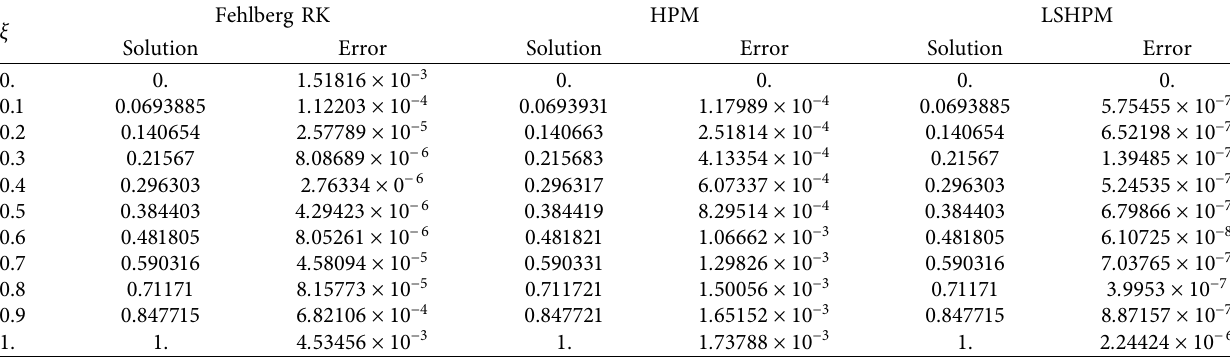
� 1 , M � 0 . 8, and c � 0 . 9 in case of slip. g p